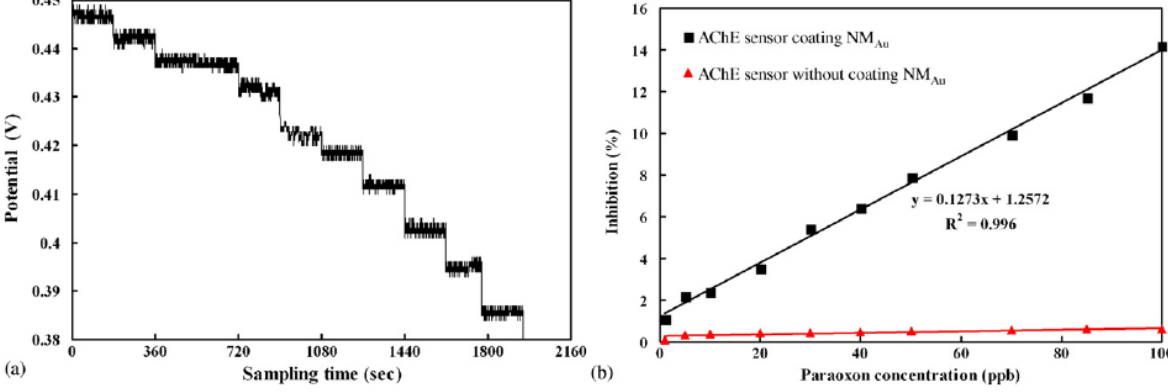
Figure 4. (a) Serial signal response of a LSPR sensor towards paraoxon in the range of 3.63 x 10 -9 M to 0.36 x 10 -6 M. The sensor is immersed in 0.05 x 10 -3 M acetylcholine chloride solution. (b) Calibration plot for the response to paraoxon in the range of 3.63 x 10 -9 M to 0.36 x 10 -6 M by two AChE biosensors with/without coating